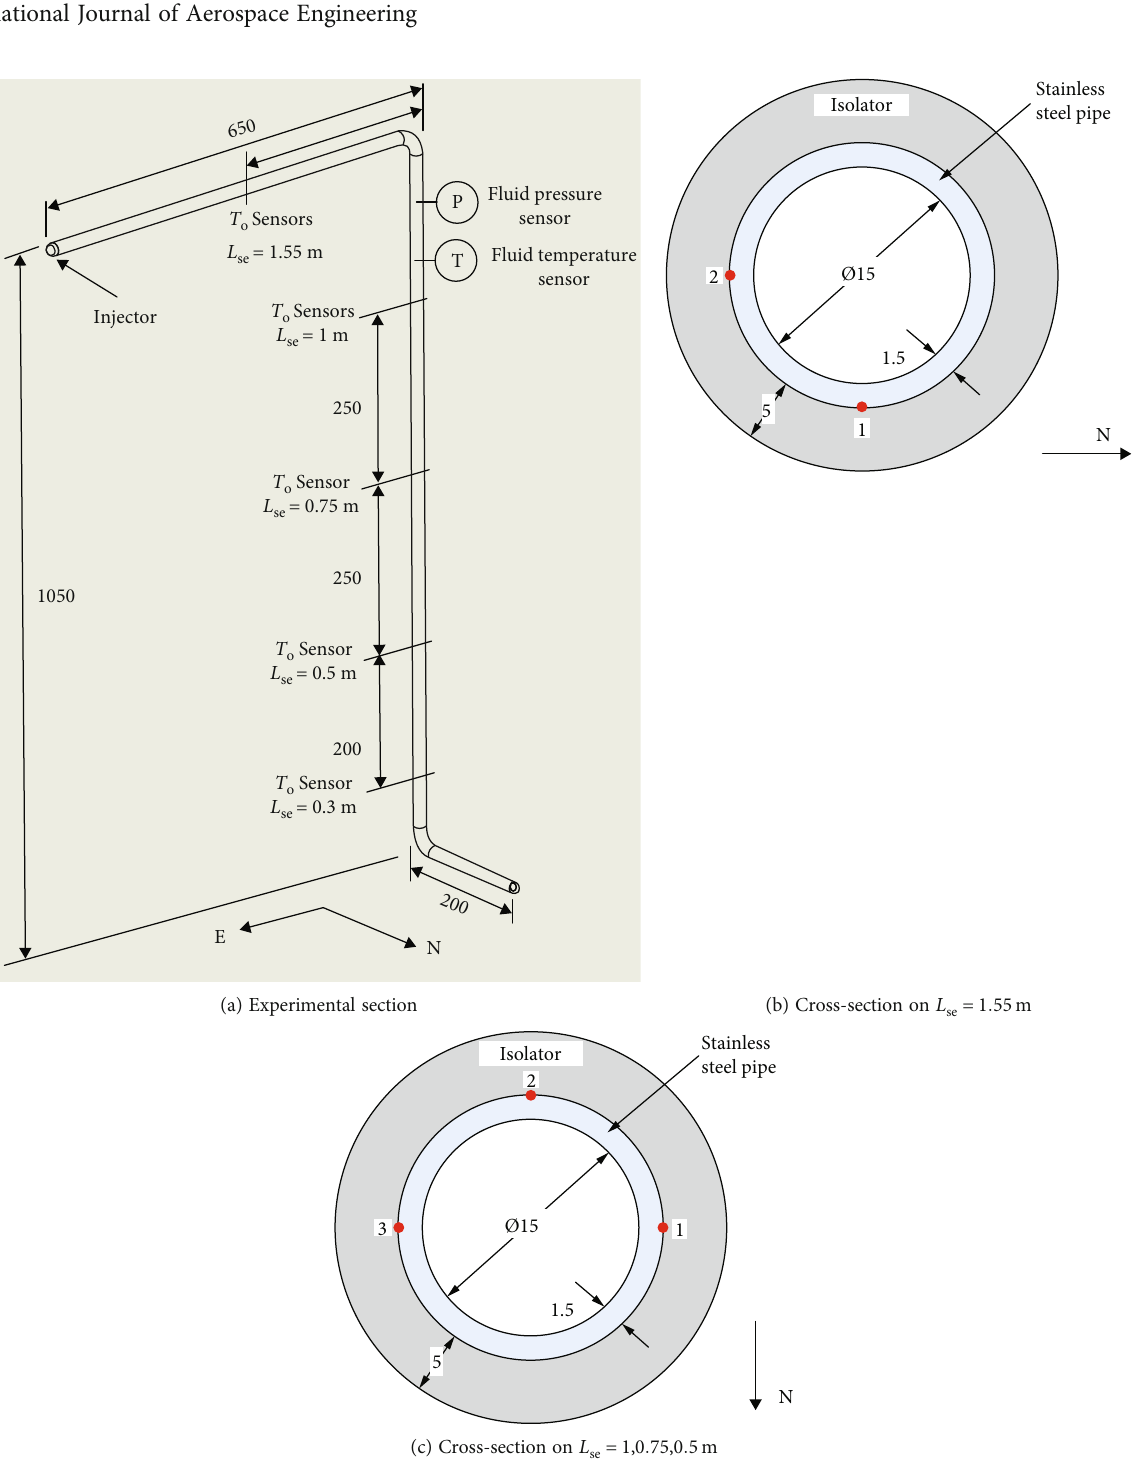
Figure 5: Details on the experimental section, unit: